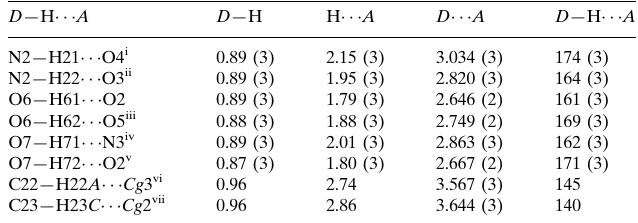
Hydrogen-bond geometry (A˚ , (cid:3)